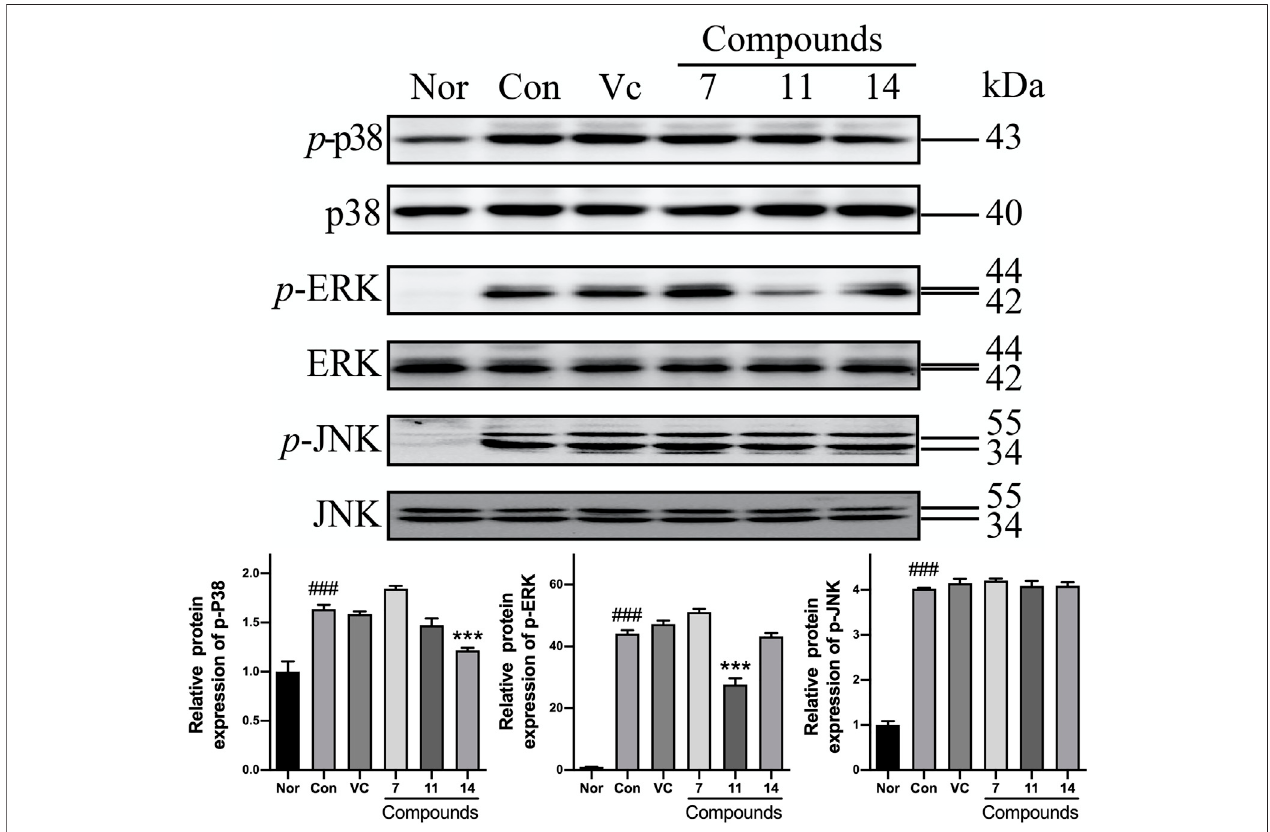
FIGURE10 | The in fl uence ofcompounds 7 , 11 ,and 14 at concentration of50 μ M on theprotein ofMAPKs in HaCaT cells. Nor: normal group; Con: UVB-induced group; Vitamin C (Vc). Values represent the mean ± SEM of three determinations ( ### p < 0.001 vs. Nor; *** p < 0.001 vs. Con).